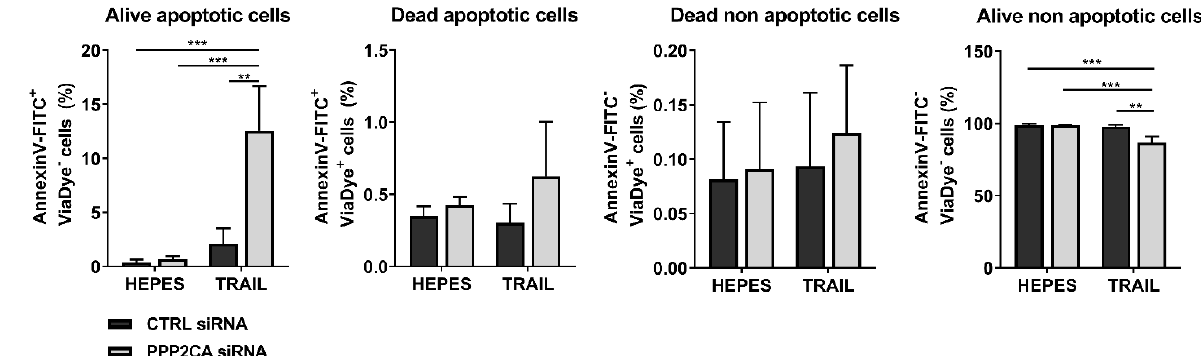
Figure 6. PP2A confines apoptotic cell death. PP2Ac siRNA- or CTRL siRNA-transfected A549 cells were treated with 50 ng/mL TRAIL diluted in HEPES (4-(2-hydroxyethyl)-1-piperazineethanesulfonic acid). The amount of apoptotic cells was analyzed 4.5 h post stimulation by a combinatory staining of Viability Dye (life/dead marker) and Annexin V by using flow cytometry. Data are represented as means + SD of three independent experiments with three biological replicates. Statistical significance was analyzed using a two-way ANOVA with ** p < 0.01 and *** p < 0.001.